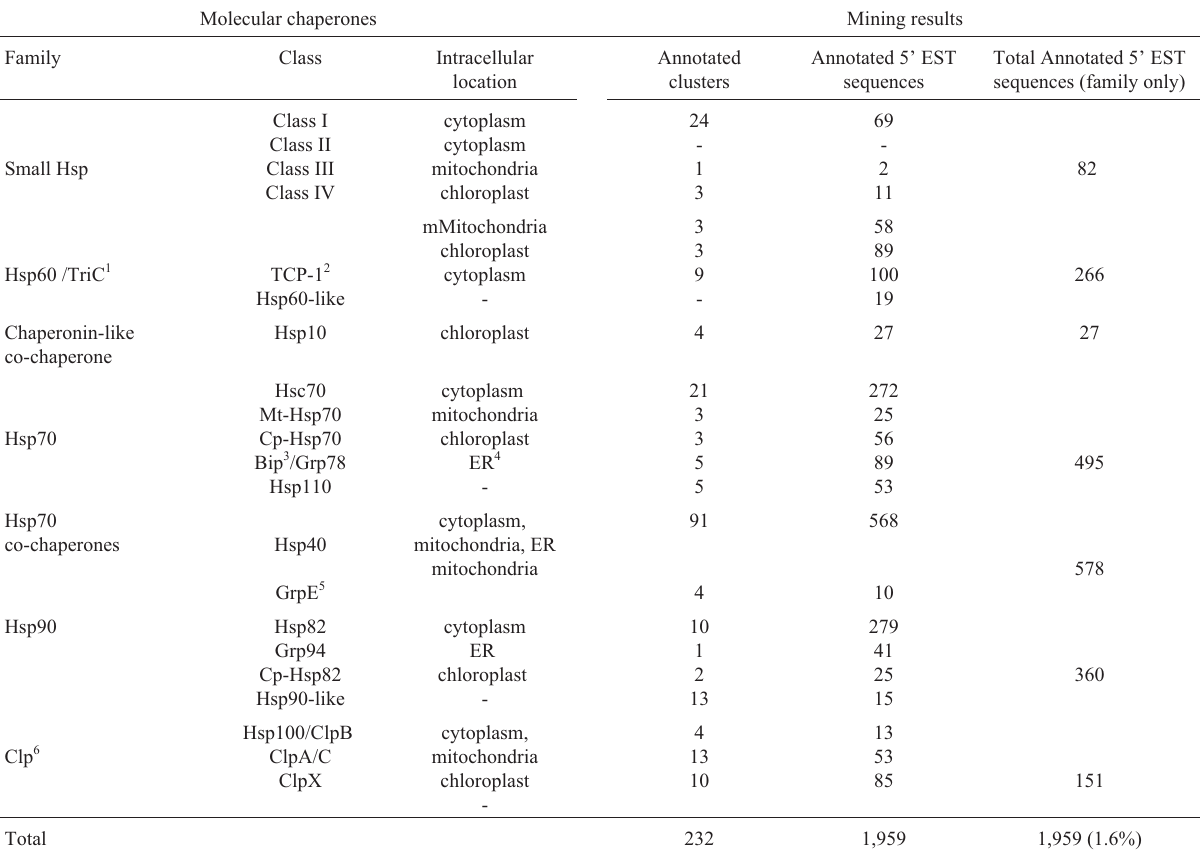
Table 2 - The main chaperone families and classes, their cellular location and the mining results. Our data mining approach found 1,959 5’ESTs belonging to the molecular chaperones category, which is about 1.6% of the total 5’ESTs sequenced by the FORESTs consortium. Molecular chaperones Mining results Family Annotated clusters